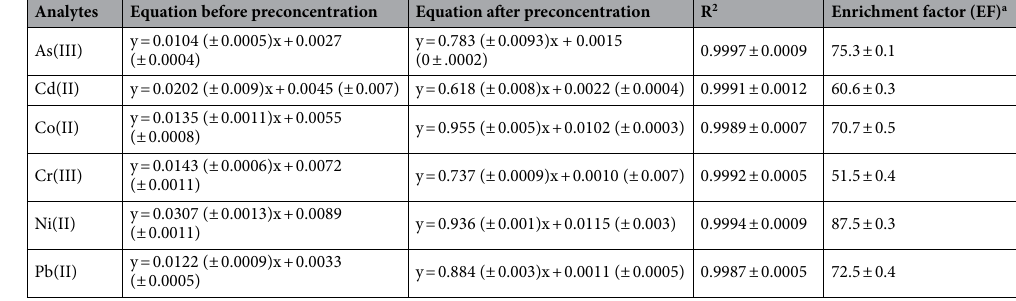
Table 2. Calibration curve equations, correlation coefficients and enrichment factors of UASPME/ICP-OES method for As(III), Cd(II), Cr(III), Co(II), Ni(II), and Pb(II) ions. a Enrichment factor was defined as the ratio between the slope of the calibration curves before and after preconcentration.